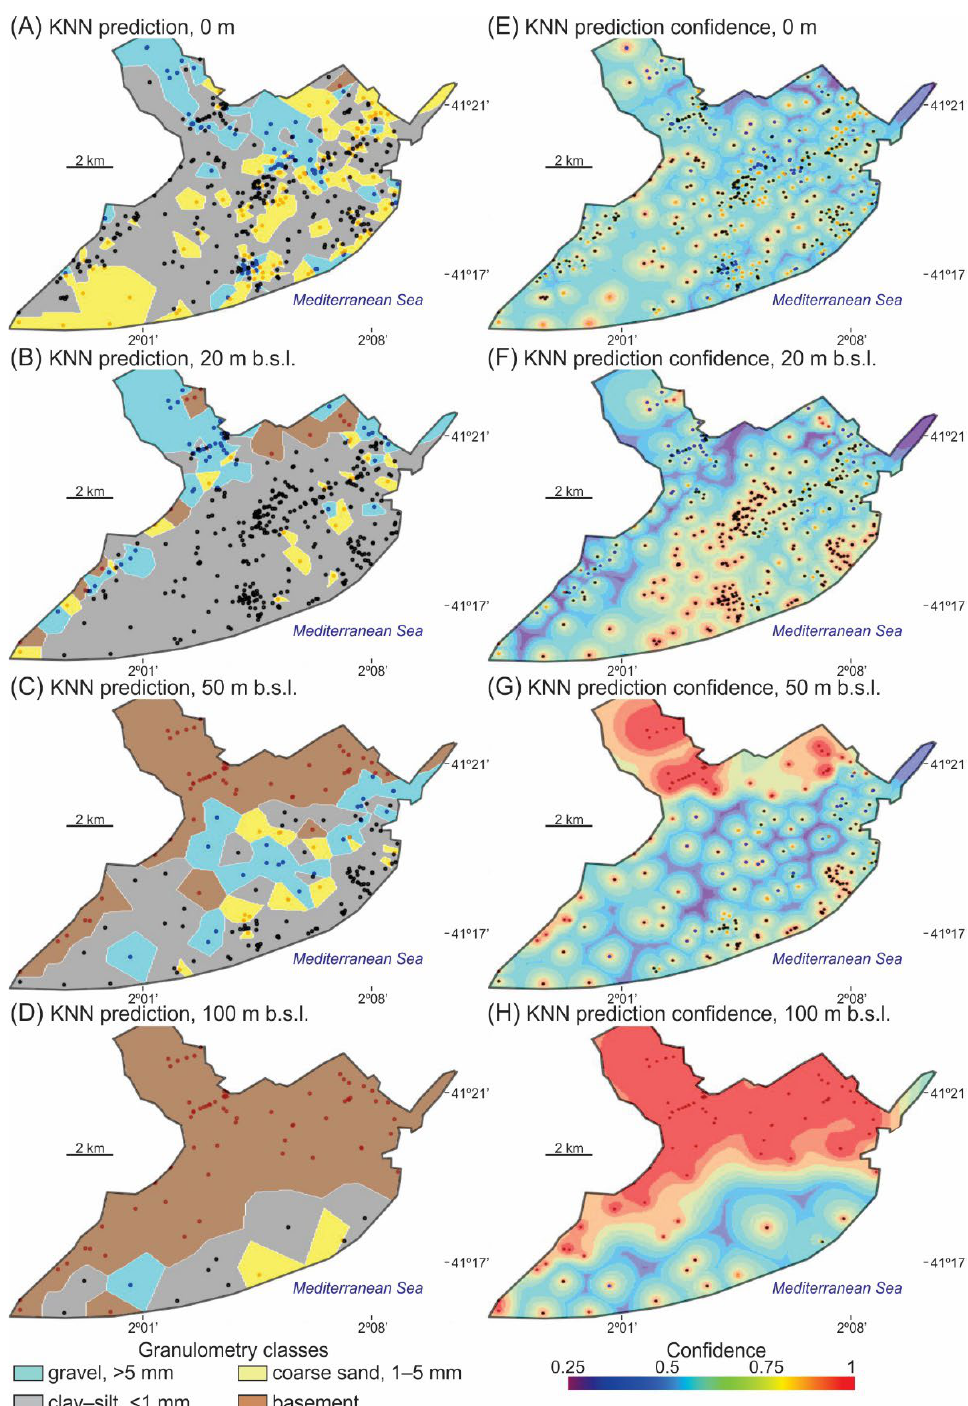
Figure 4. Horizontal sections at 0, 20, 50 100 m b.s.l. of the grain-size (or granulometry) classes generated by the KNN algorithm in the onshore Quaternary LRD [18]. ( A − D ) The KNN predictions, with grain-size data classified into the gravel (>5 mm, cyan), coarse sand (1–5 mm, yellow), clay–silt (<1 mm, gray) and basement (brown) classes. ( E − H ) The corresponding KNN prediction confidences are expressed in the dimensionless 0.25–1 range. Points A through H represent the boreholes with grain-size data at the mapped depth.